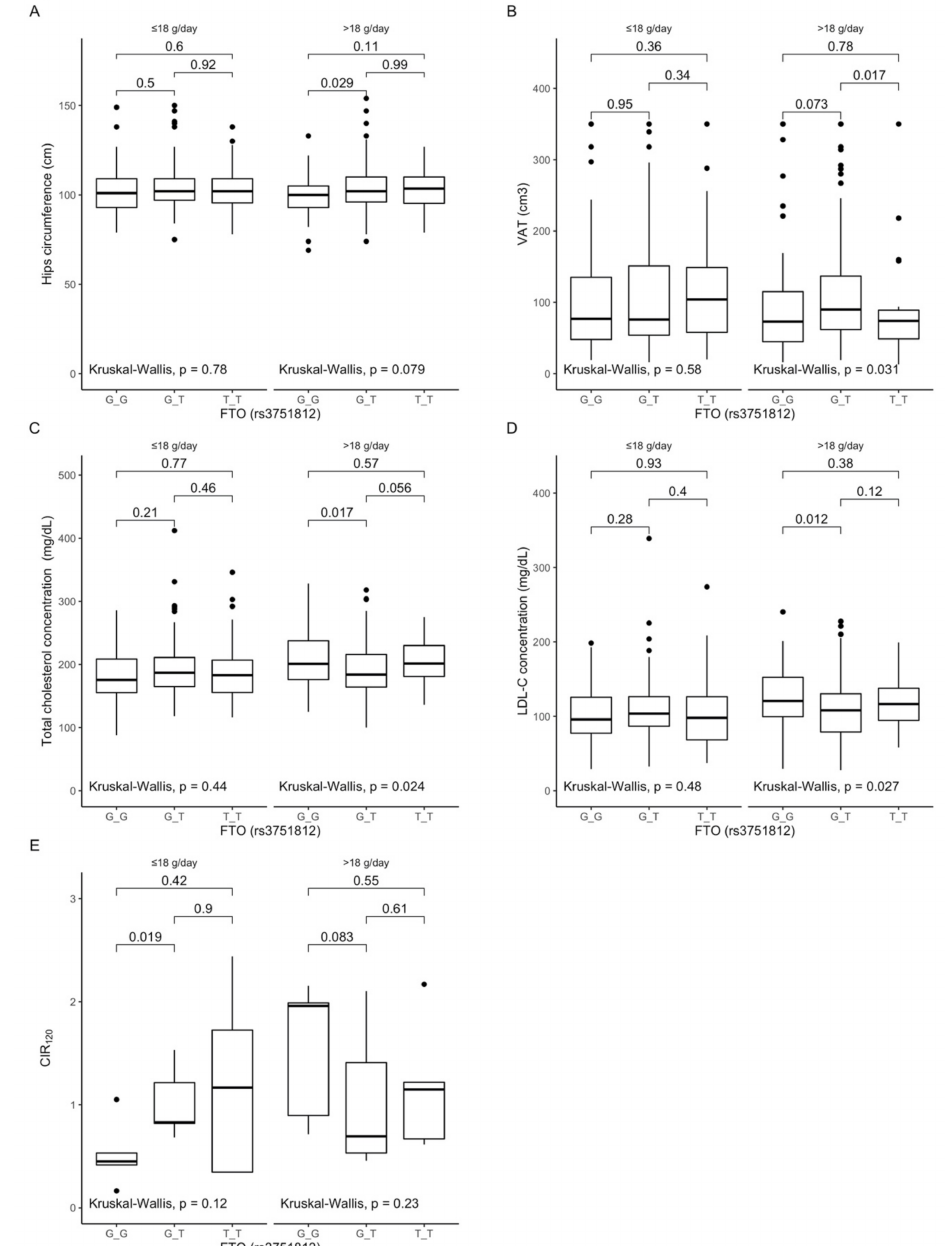
Figure 1. Association of the FTO rs3751812 genotypes with ( A ) Hip circumference (cm); ( B ) Visceral adipose tissue (VAT) (cm 3 ); ( C ) Total cholesterol concentration (mg/dL); ( D ) LDL-C concentration (mg/dL); ( E ) CIR 120 by dietary fiber intake strata: ≤ 18 g/day and >18